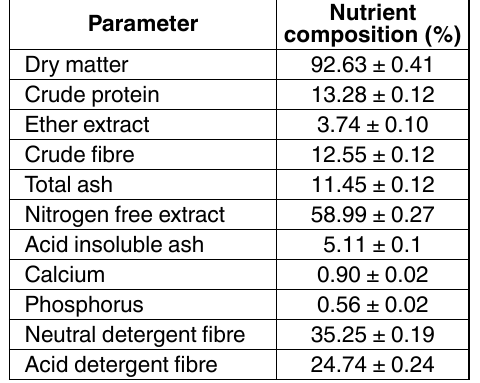
Table 2. Chemical composition of TMR 1